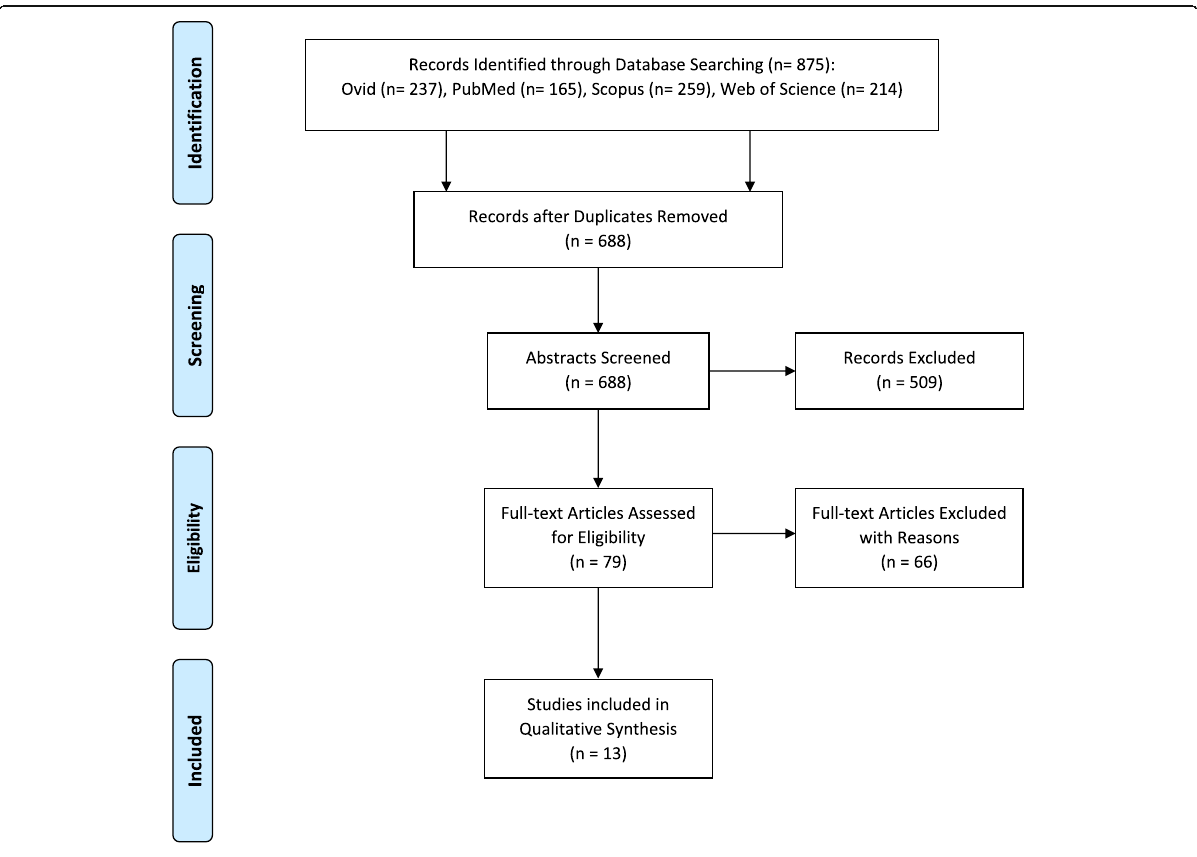
Fig. 1 PRISMA flow diagram of literature